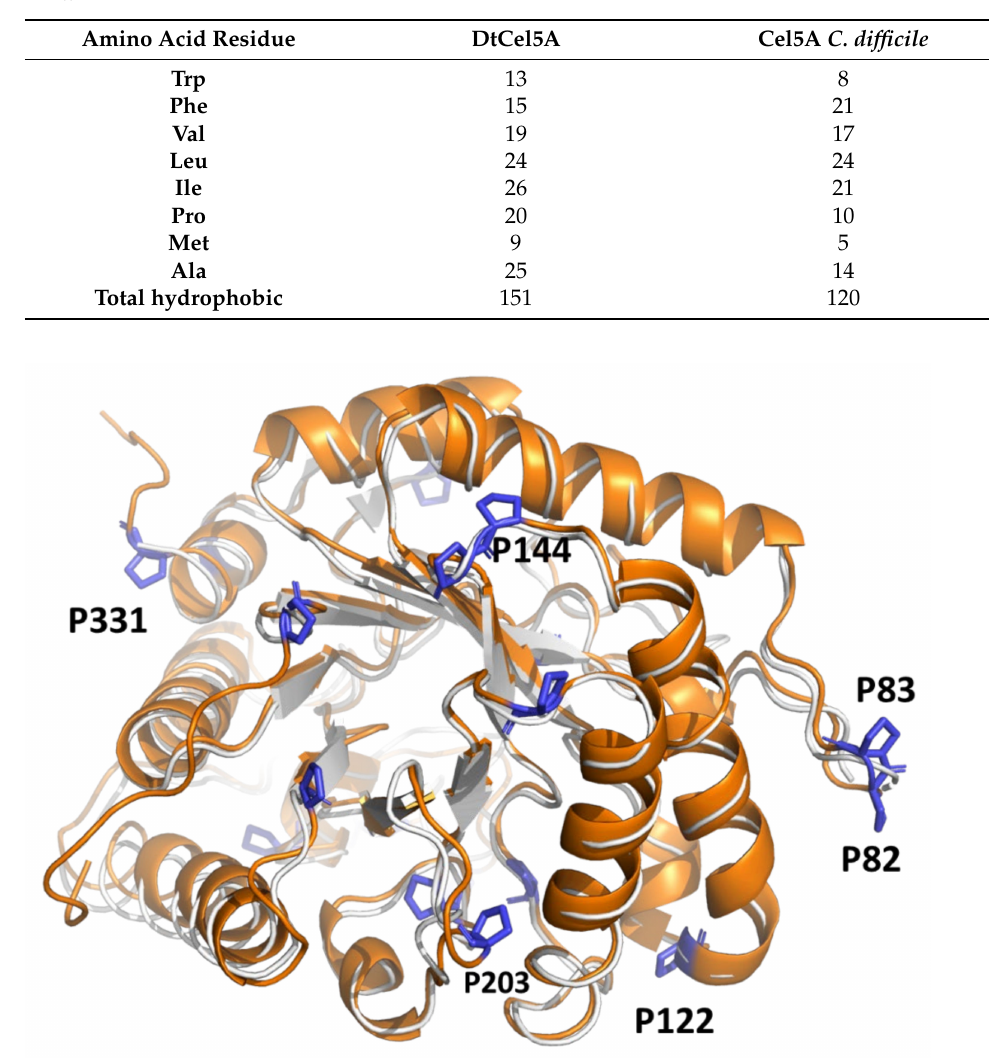
Figure 5. Cartoon representation of the superposition of structures of DtCel5A (orange) and Cel5A from C. difficile (white, pdb code 6uje). Proline residues of DtCel5A are drawn in blue stick represen-